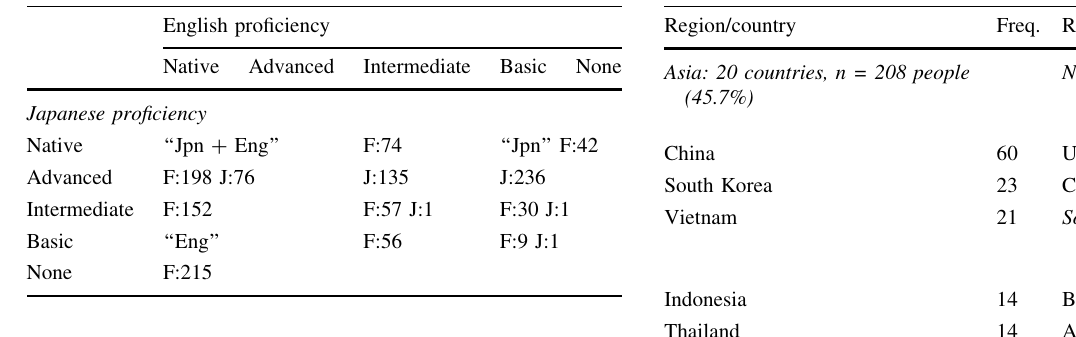
Table 3 Categorization of respondents according to language proficiency